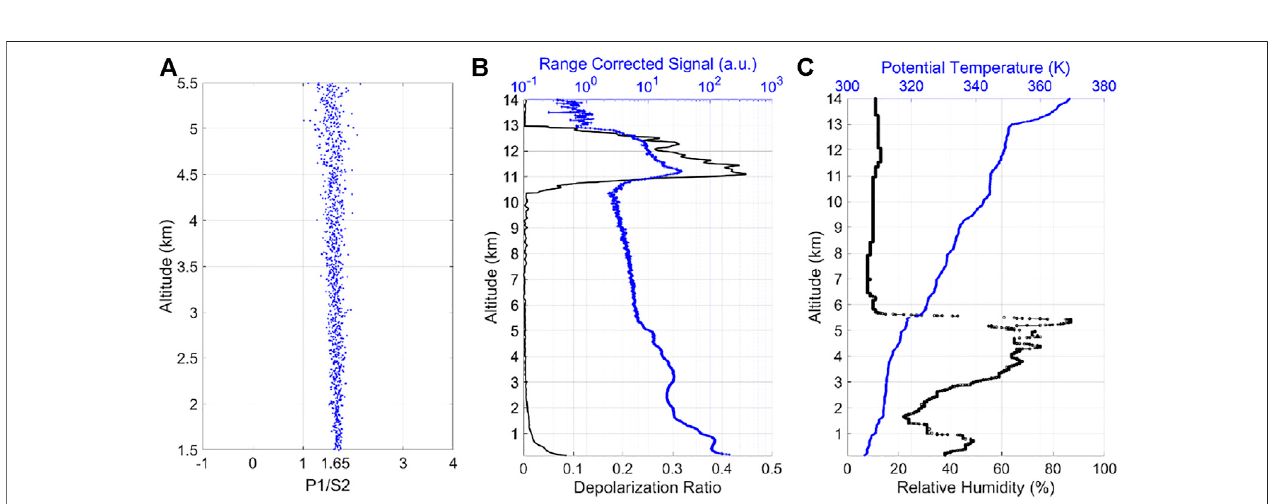
FIGURE 8 | (A) Correction factor K . (B) The pro fi les of range corrected signal and depolarization ratio at 19:15 on 20 June 2019. (C) The pro fi les of potential temperature and relative humidity at 19:15 on 20 June 2019.